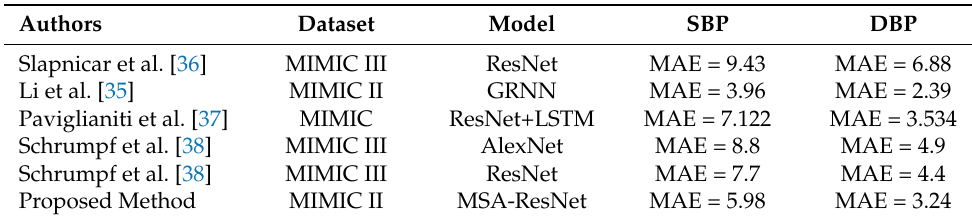
Table 4. Comparison with related work